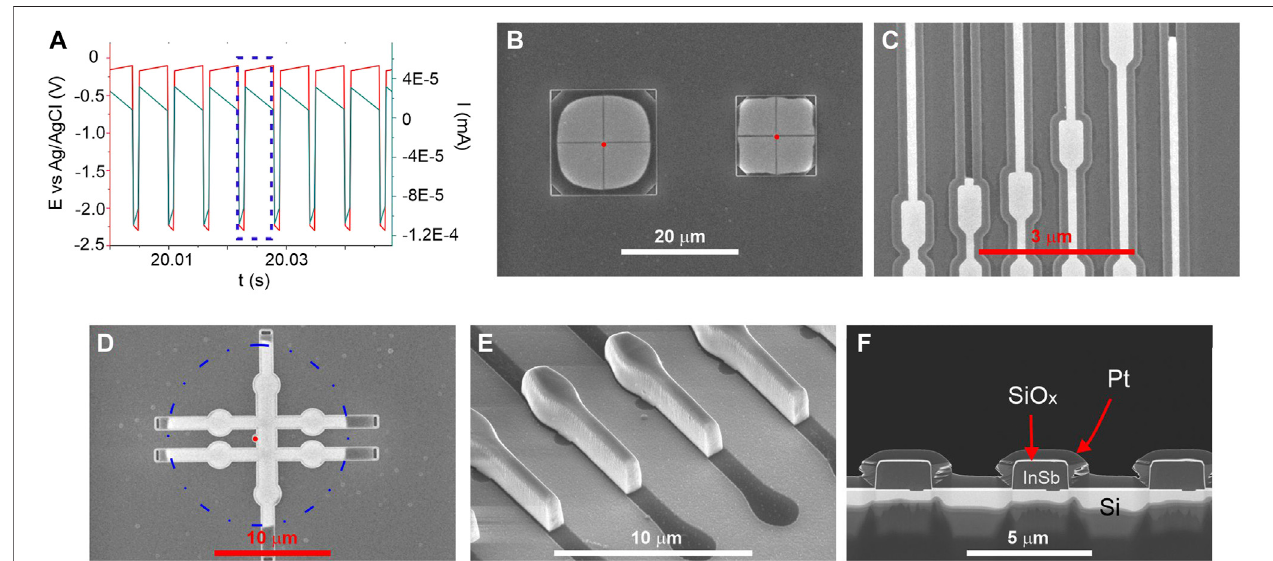
FIGURE 2 | (A) Section of typical potential pulse sequence. Blue dotted frame marks one cycle. (B – D) SEM images of fi lled SiO x templates with different shapes and sizes. Seed hole marked with the red dot. (E) SEM image of InSb deposit after partial removal of the SiO x template. The dark shade marks the area of the template whichwasleftun fi lled. (F) Across-sectionof fi lledtemplatesexposingtheseedregions.BothSiO x capping(thinbrightpartontopofthedeposit)andPtproctective(thick grey part on top of the SiO x ) layers are